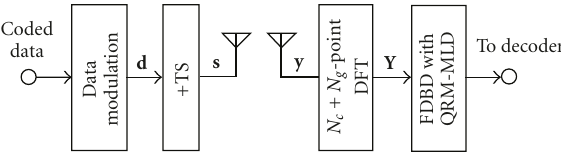
Figure 2: TA-SC transmission system model.